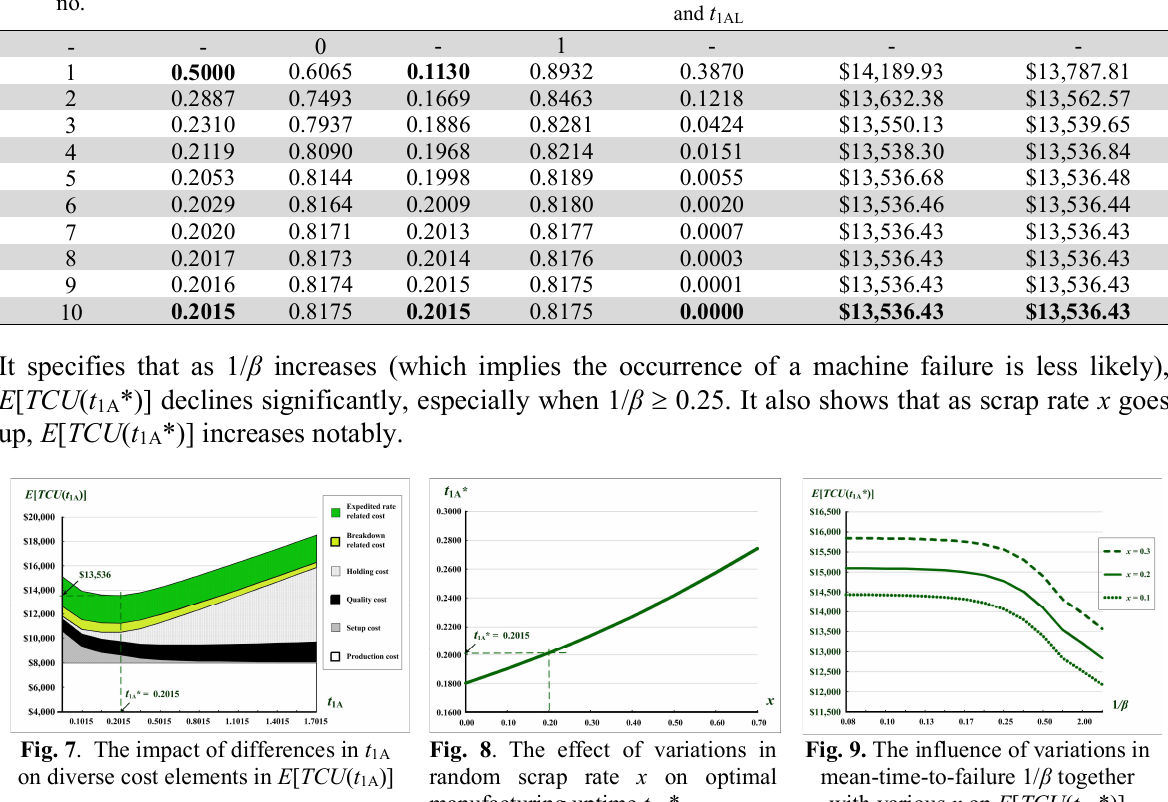
Fig. 7 . The impact of differences in t 1A Fig. 8 . The effect of variations in